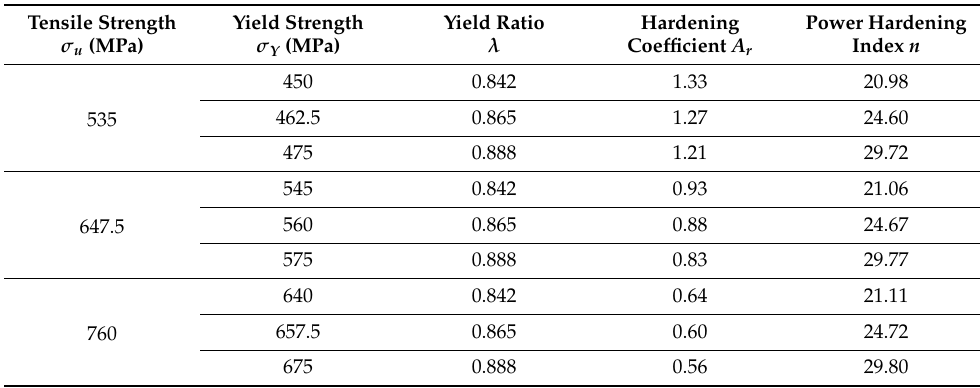
Table 1. Material performance